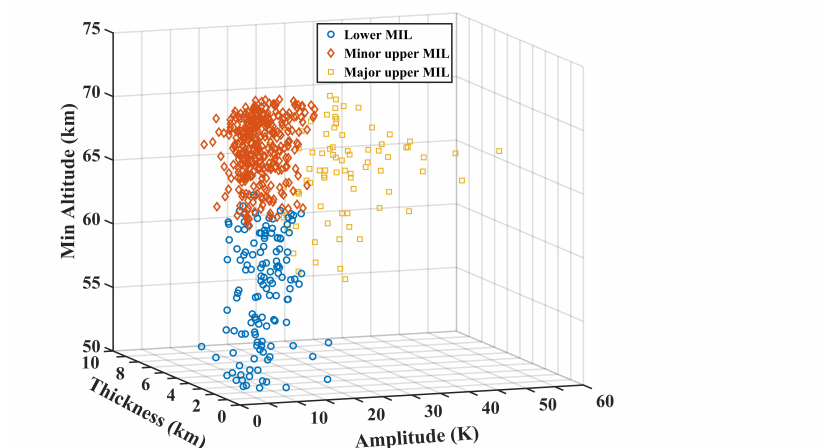
Figure 5. Observation of MIL’s groups from 1978 to 2019 based on k-mean clustering. There are three main groups. The first group is shown by blue dots, while groups 2 and 3 are shown by orange and yellow, respectively.